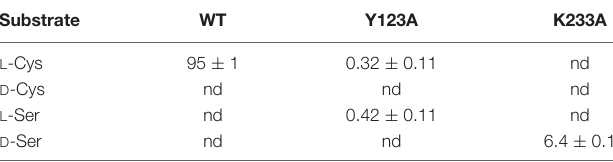
TABLE 3 | Substrate specificity of β -lyase